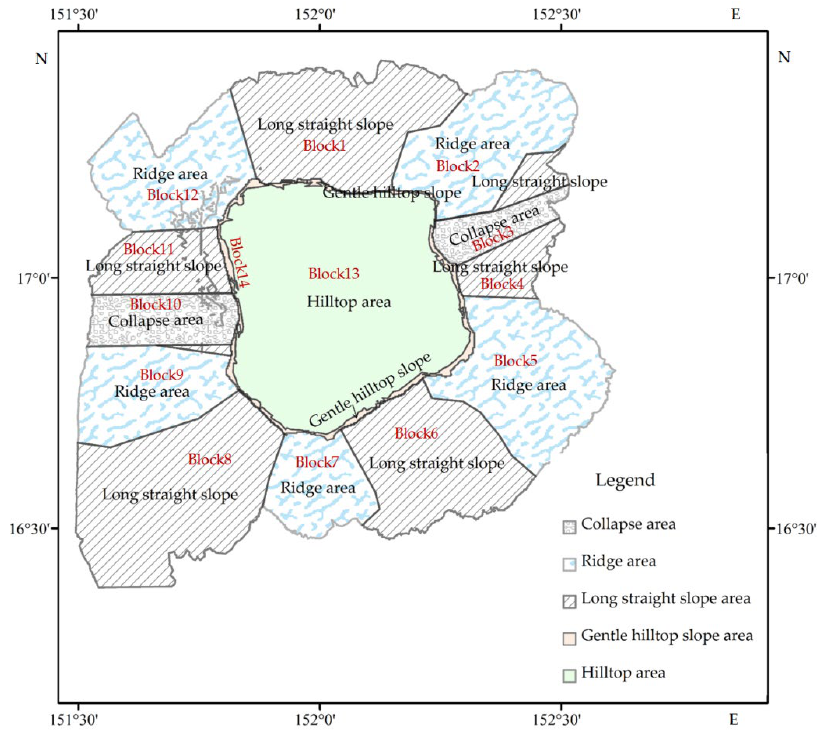
Figure 13. Geological units according to the topographic and geomorphic classification.